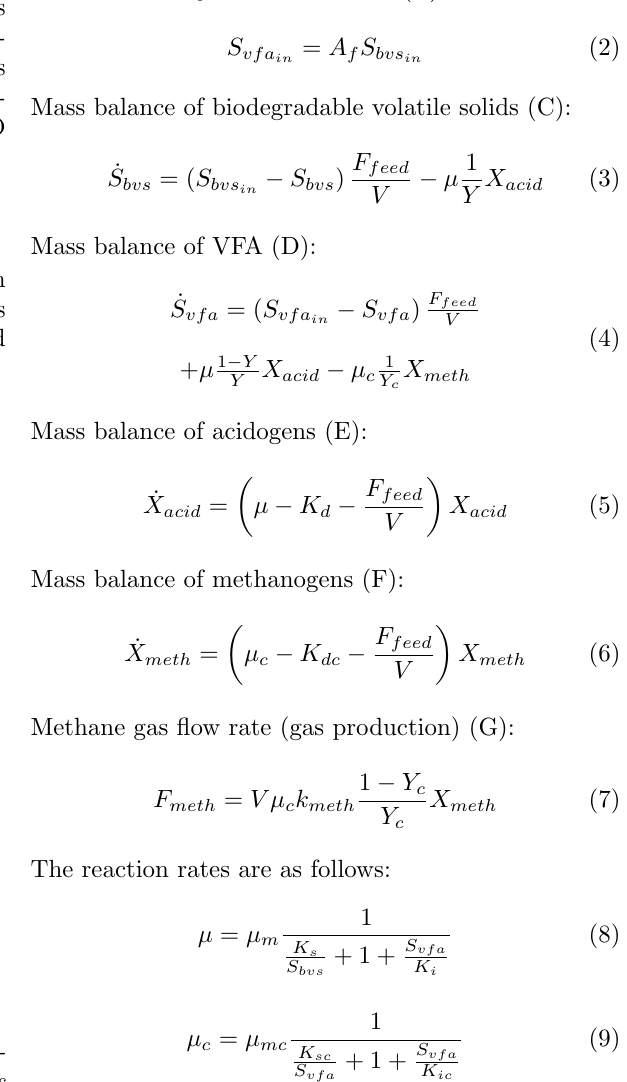
Figure 2: The anaerobic digestion steps forming the ba- sis of Hill’s model. The alphabetic indicators refer to Hill’s model, eqs. (1)-(10). The sym- bols resemble those in Zaher et al.